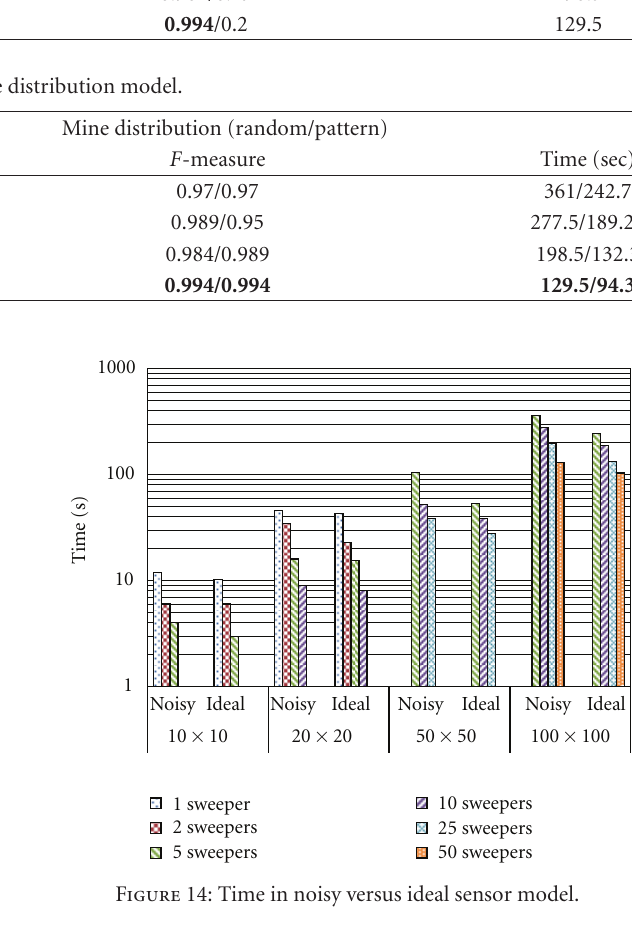
which is the 100 × 100 area are shown in Tables 2, 3, and 4. The best situation in each case is highlighted with bold font.